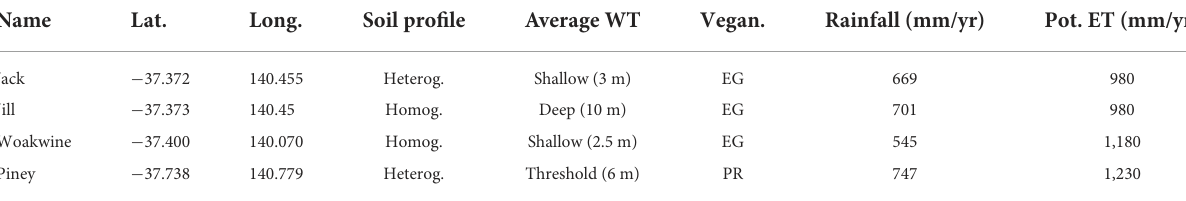
TABLE 1 Name, coordinates, and characteristics of the silviculture sites (Benyon et al.,